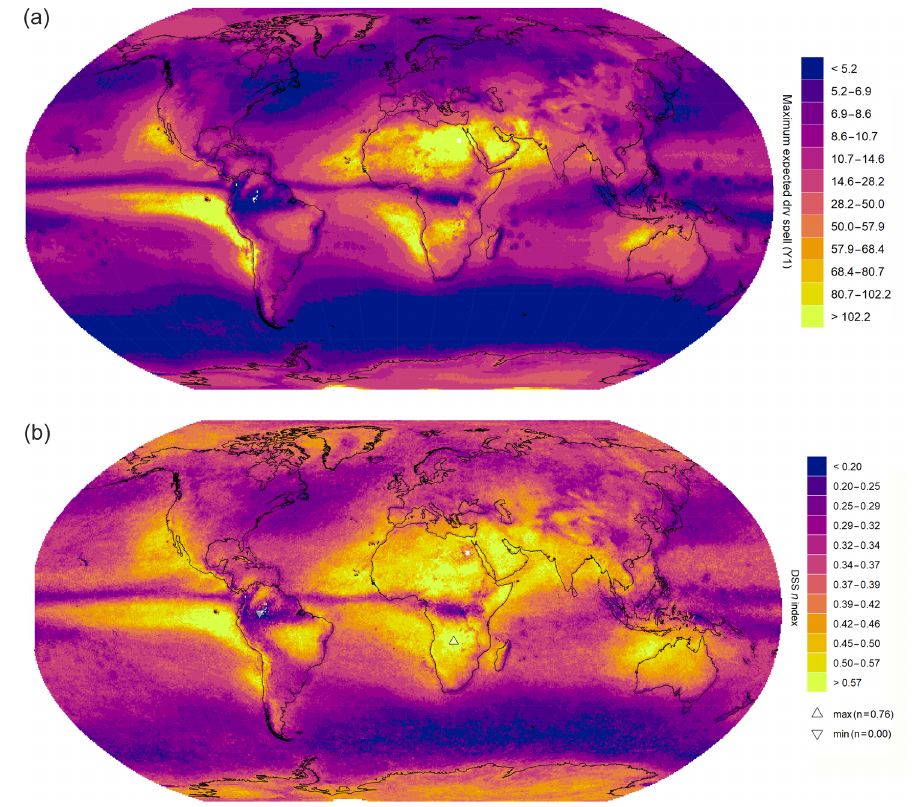
Figure 1. Spatial distribution of regularity of the lacunarity, averaging for all DSS events: (a) maximum expected dry spell ( Y 1 ) and (b) DSS n